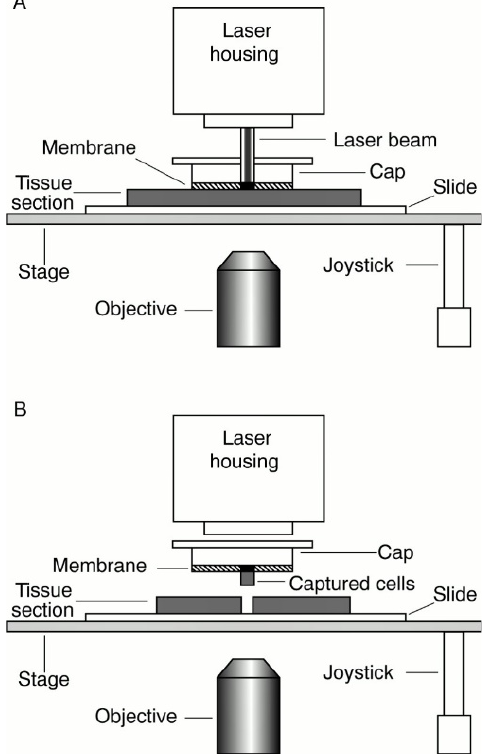
Figure 2. Schematic diagram of LCM: ( A ) in-house laser capturing the samples in marked trajectory using the laser beam; ( B ) the cap lifting the captured samples in the slides [47]. Reproduced from laser capture microdissection in pathology, Falko Fend and Mark Raffeld, Vol:53:666–672; 2000 with permission from BMJ Publishing Group Ltd.